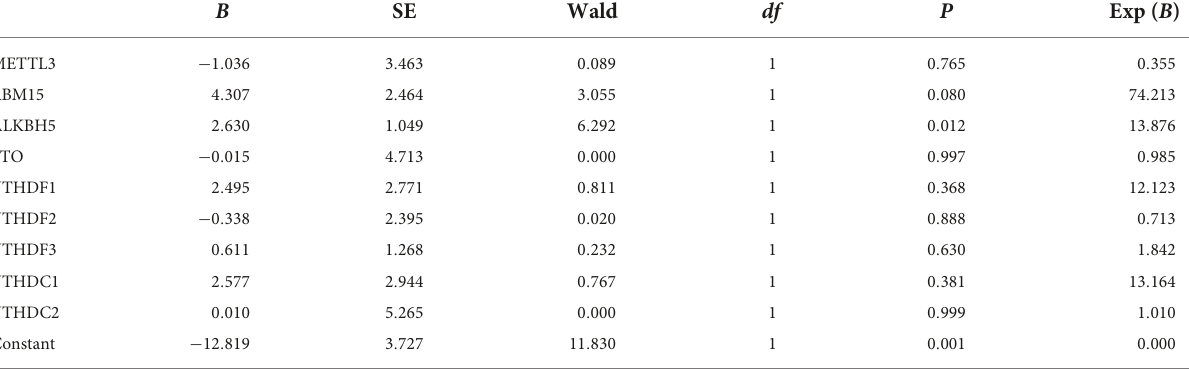
TABLE 3 The expression of METTL3, RBM15, ALKBH5, YTHDF1, YTHDF2, YTHDF3 YTHDC1, and YTHDC2 in